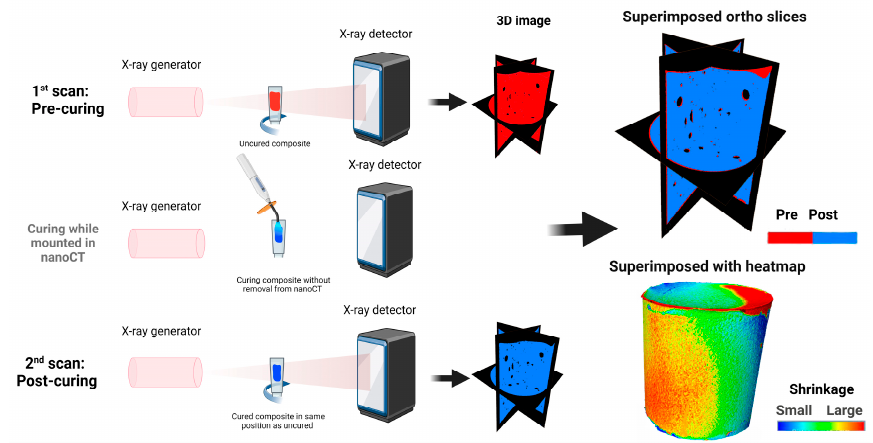
Figure 5. Schematic drawing on how the 3D shrinkage was assessed with nano-CT. The uncured composite was scanned, and a 3D model of the pre-curing was made. The same composite was cured inside the nano-CT with the same lamp and exposure time as described in the Materials and Methods section. The cured composite was scanned again. Since the composite was never removed from the nano-CT, it is possible to superimpose the pre- and post-curing, allowing for exact quantification and visualization of where the shrinkage occurred.